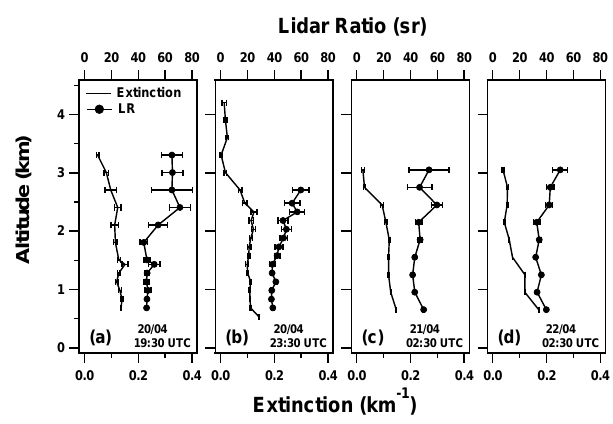
Fig. 4. Vertical profiles of the aerosol extinction coefficient (solid line) and of the lidar ratio (full dots) retrieved from nighttimes lidar Figure 4 (M. R. Perrone et al.) measurements at different hours on 20, 21, and 22 April 2010.